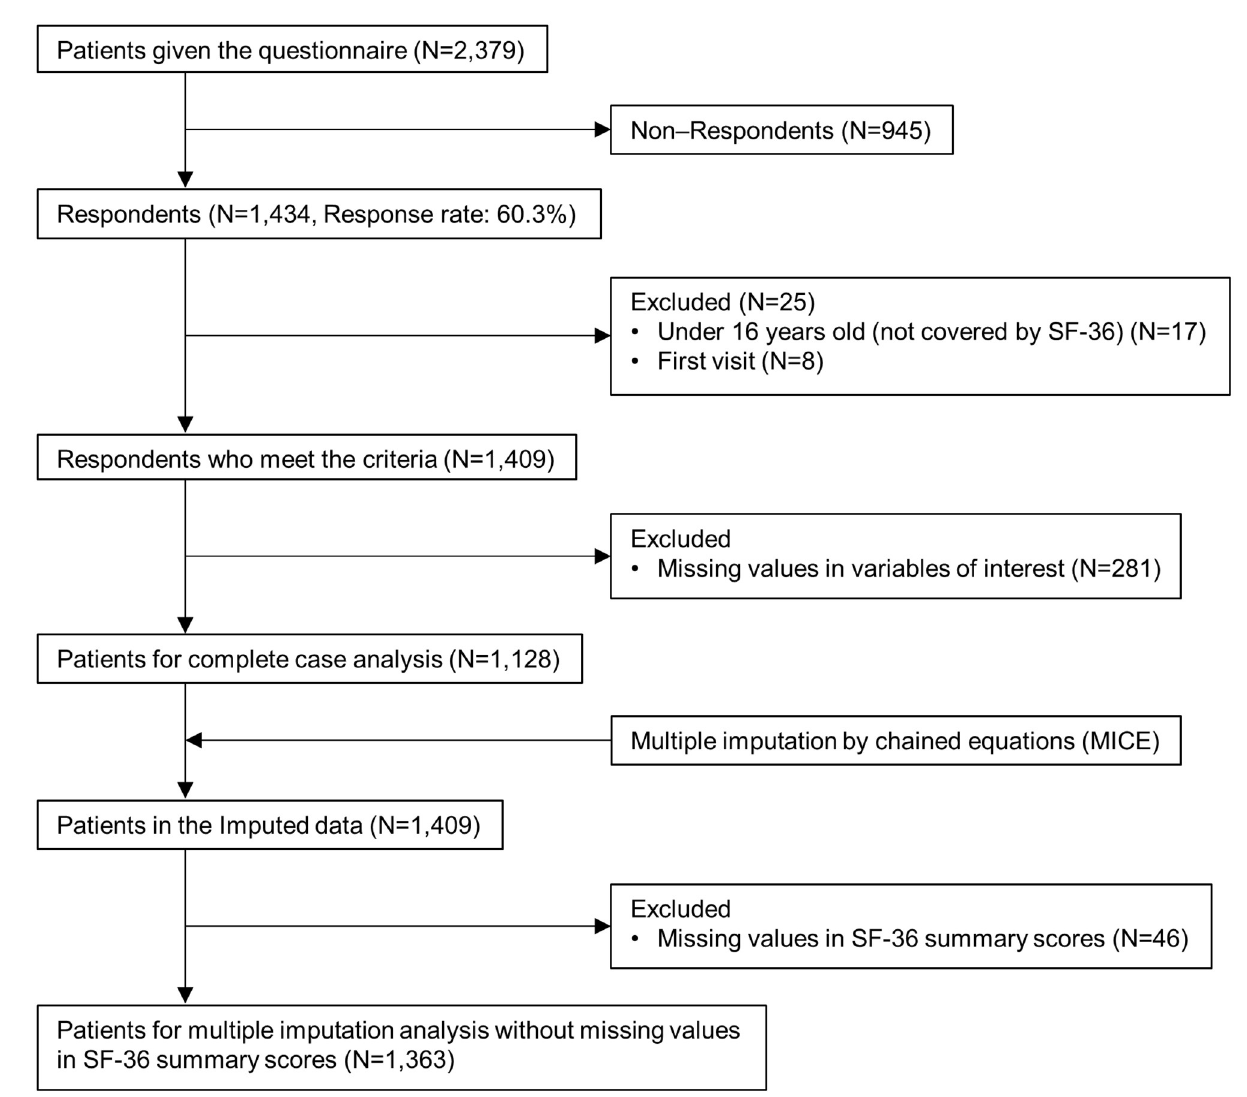
Fig 1. Study flow